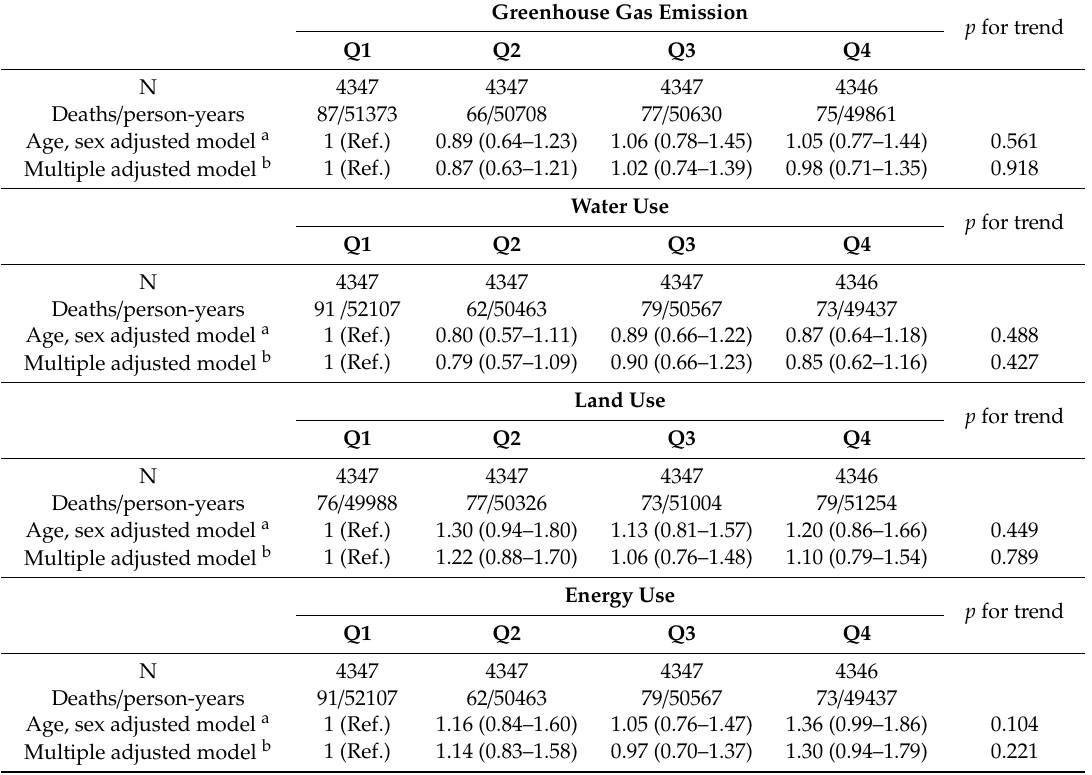
Table 3. Risk for all-cause mortality (hazard ratio and 95% confidence intervals) of the 17,387 participants of the SUN cohort assessed in the current study, 1999–2019, according to energy-adjusted quartiles of the indicated dietary environmental